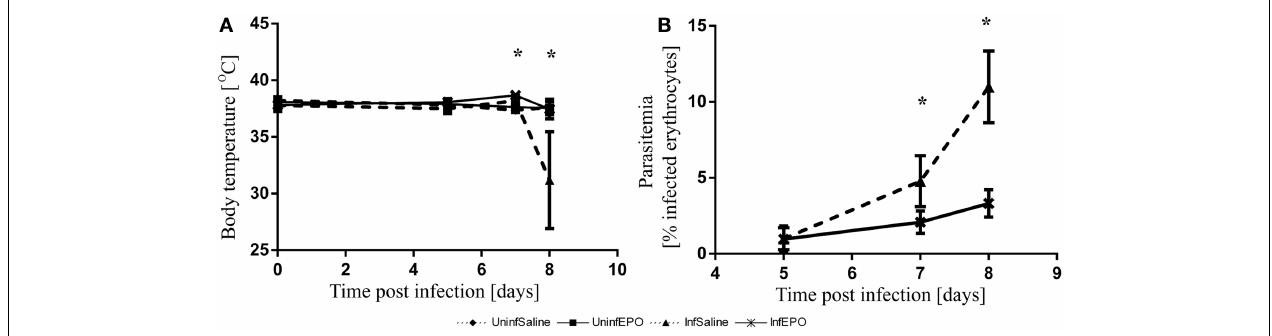
FIGURE 1 | Progression of body temperature and parasitemia during the course of infection . (A) Body temperature remained stable until day 6 p.i. and increased slightly in infected mice. InfSal mice displayed clinical signs of CM at day 8 p.i. and had significantly lowered body temperature ( p < 0.005).